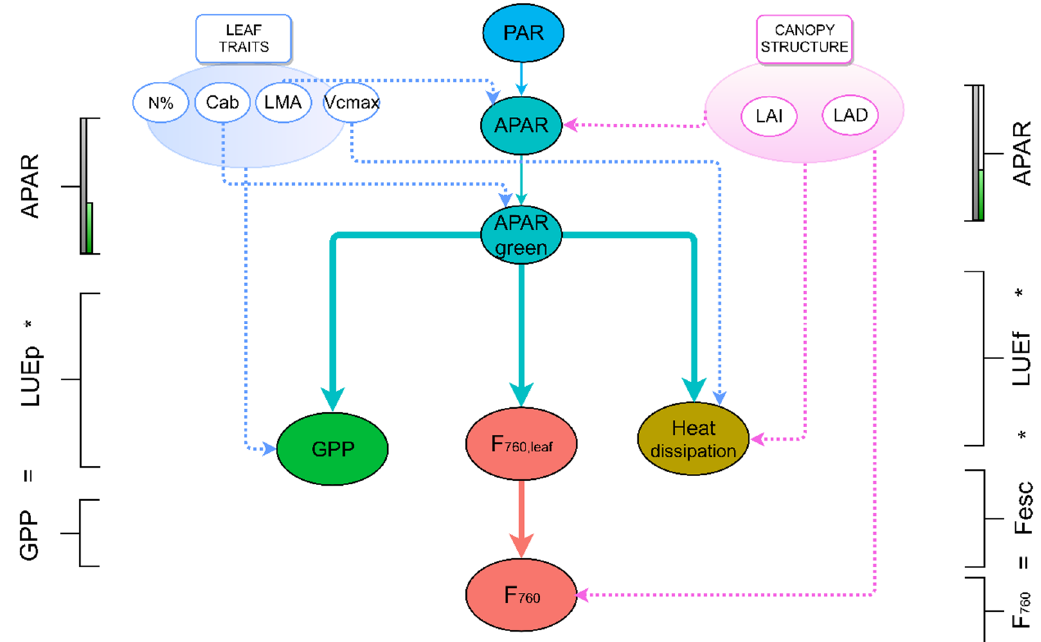
Figure 1. Energy partitioning at the leaf and canopy level representing the processes involved in the photosynthetic light use e ffi ciency model (GPP = APAR x LUE p ) and fluorescence light use e ffi ciency model (F 760 = APAR *LUE f * Fesc) are represented with solid arrows. Dotted arrows represent the hypothesized relationship between leaf traits, canopy structure and the various processes related to the allocation of energy and transfer of SIF within the canopy. Photosynthetic active radiation (PAR); absorbed (by vegetation) photosynthetic active radiation (APAR); PAR absorbed by chlorophyll a and b molecules (APAR green ), represented as the green bar in the equations on both sides of the figure; gross primary production (GPP); sun-induced fluorescence emitted by all leaves at 760 nm (F 760leaf ); sun-induced fluorescence at 760 nm observed at top of canopy (F 760 ); nitrogen concentration on a mass basis (N%); chlorophyll a and b on a mass basis (Cab); leaf mass per area (LMA); maximum carboxylation rate (Vcmax); leaf area index (LAI); leaf angle distribution